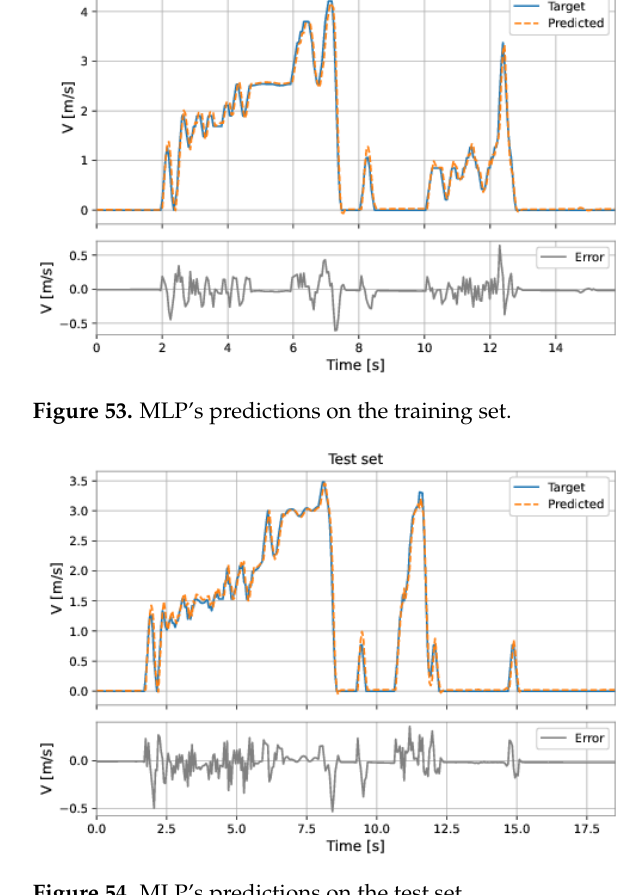
Figure 54. MLP’s predictions on the test